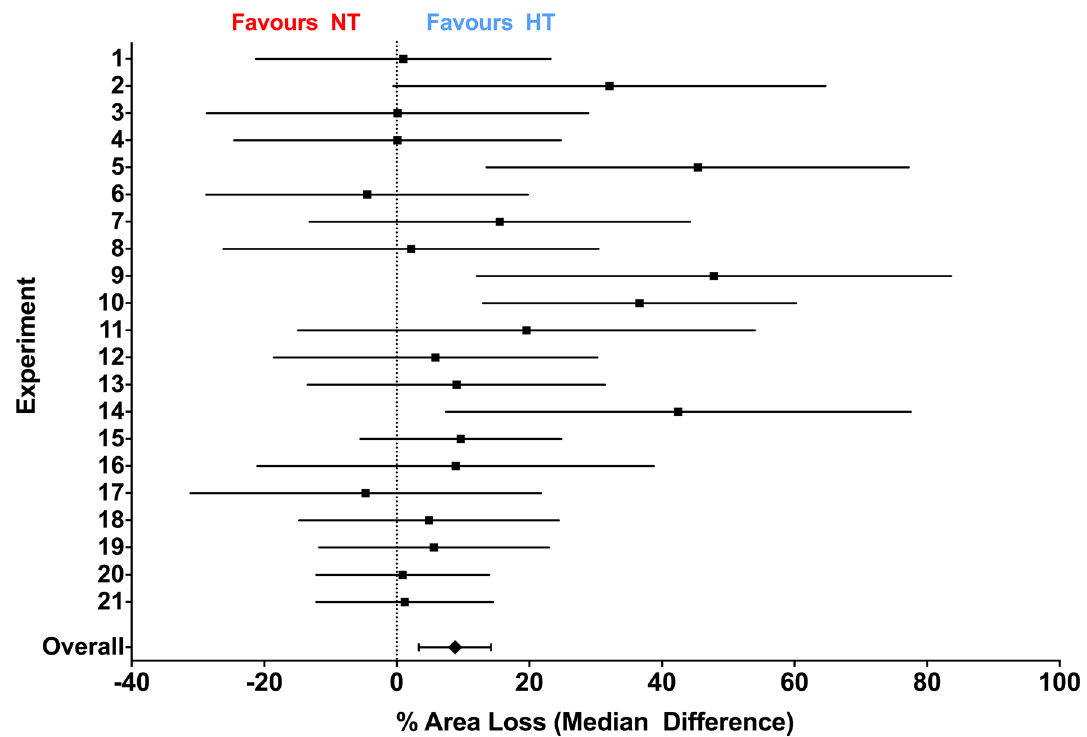
Figure 2. Median difference in area loss between NT and HT. Median difference (with 95% CI) in area loss between the NT and HT groups in each individual experiment, and overall. Experiments are numbered in chronological order. Of the 21 experiments, 15 favoured HT, and the overall median difference (absolute reduction in area loss in the HT group) was 8.8% severity, with the greatest difference between groups at a global pathology score of 3.0 (Fig. 3b). Regional pathol- ogy scores in the NT group were 4.0 (3.5–4.0) in the hippocampus, 3.5 (3.0–4.0) in the thalamus, 3.0 (2.5–3.5) in the basal ganglia, and 3.65 (3.3–3.8) in the cortex (Supplemental Figure S1). Significant neuroprotection was seen in all regions in the HT group, with corresponding scores of 2.0 (2.0–3.0) in the hippocampus ( p < 0.001),